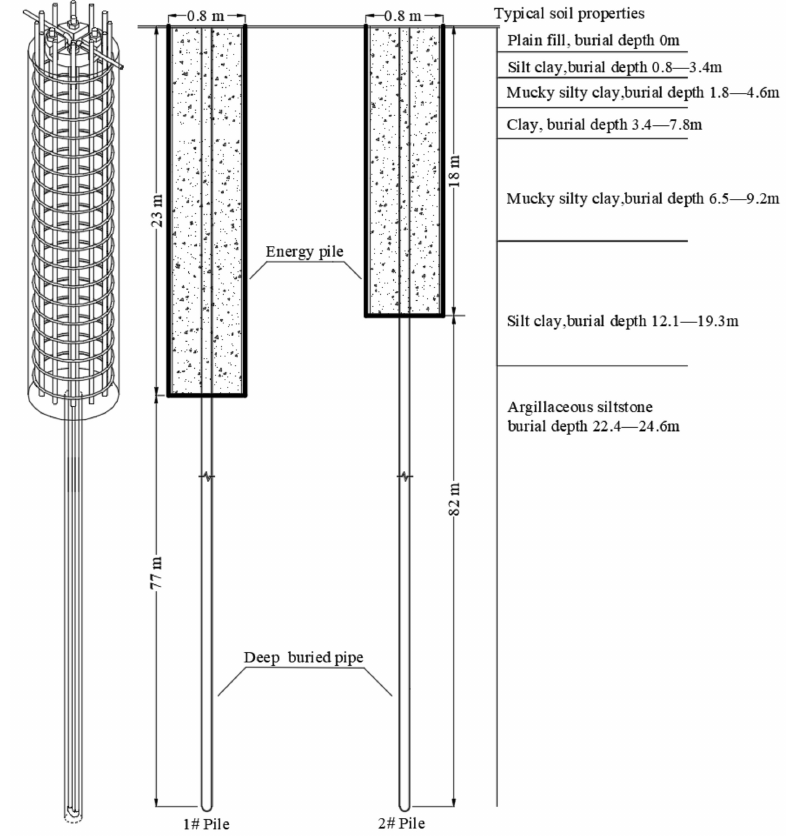
Figure 1. Soil layer distribution of energy pile.